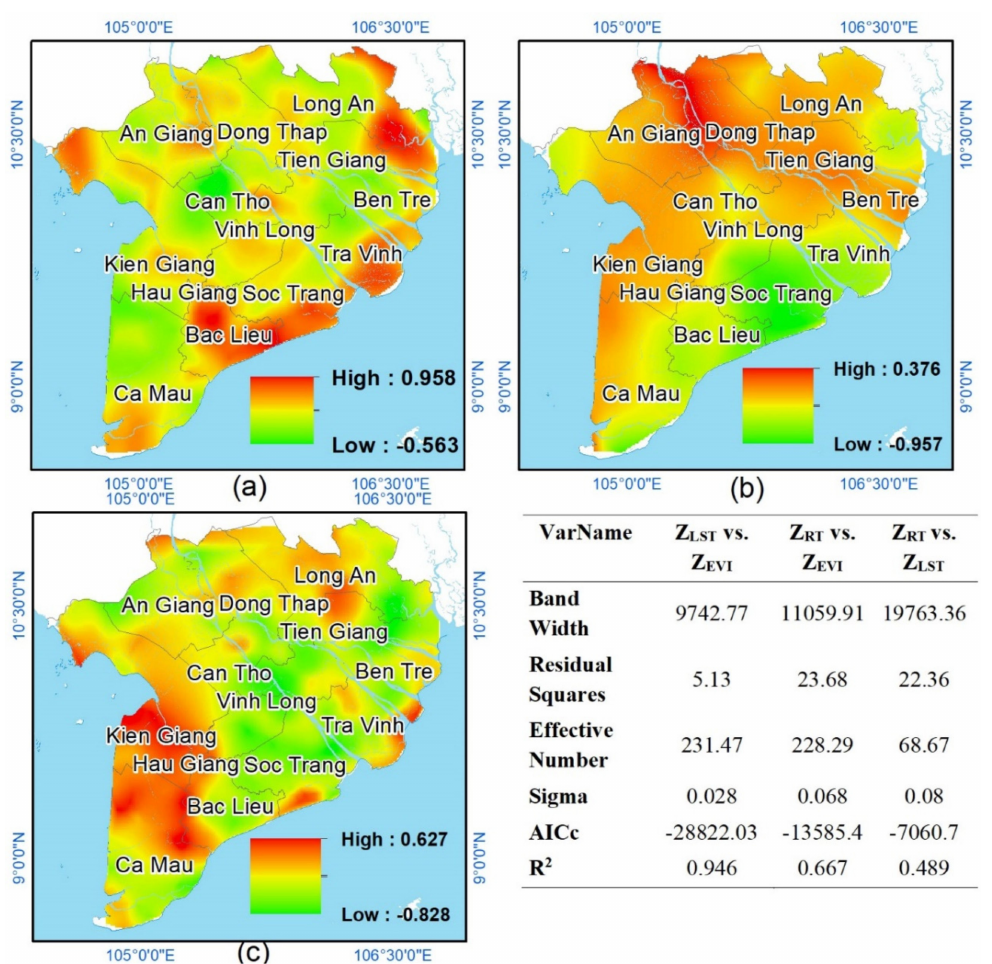
Figure 4. GWR analysis between ( a ) Z RT and Z EVI ; ( b ) Z RT and Z LST , and ( c ) Z LST and Z EVI local correlation coe ffi cients ( p <